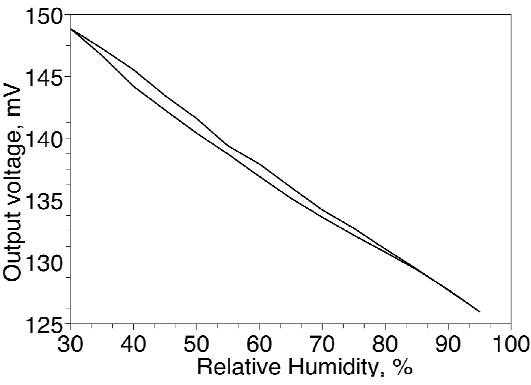
Figure 5. Hysteresis of humidity sensor at 25 °C.